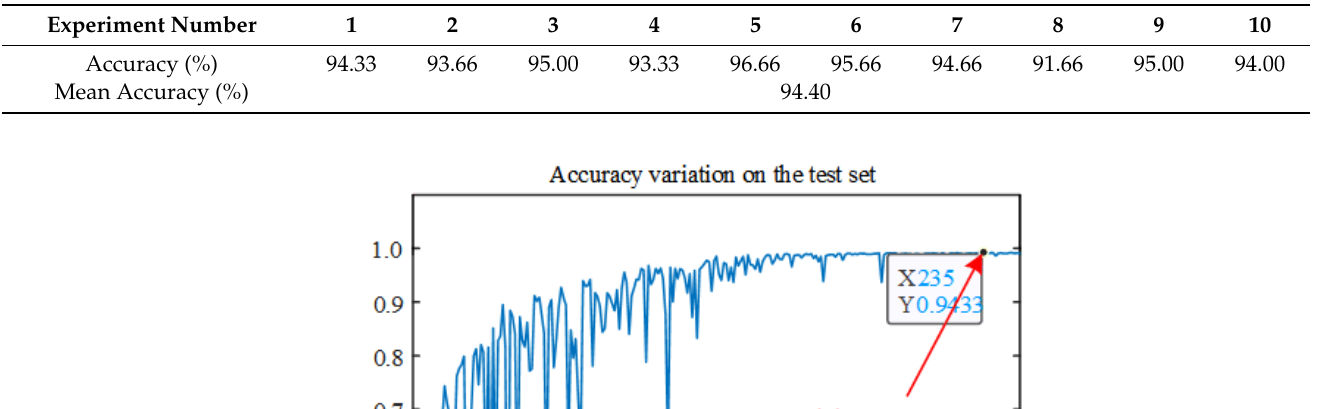
Table 4. Results of 10 experiments.